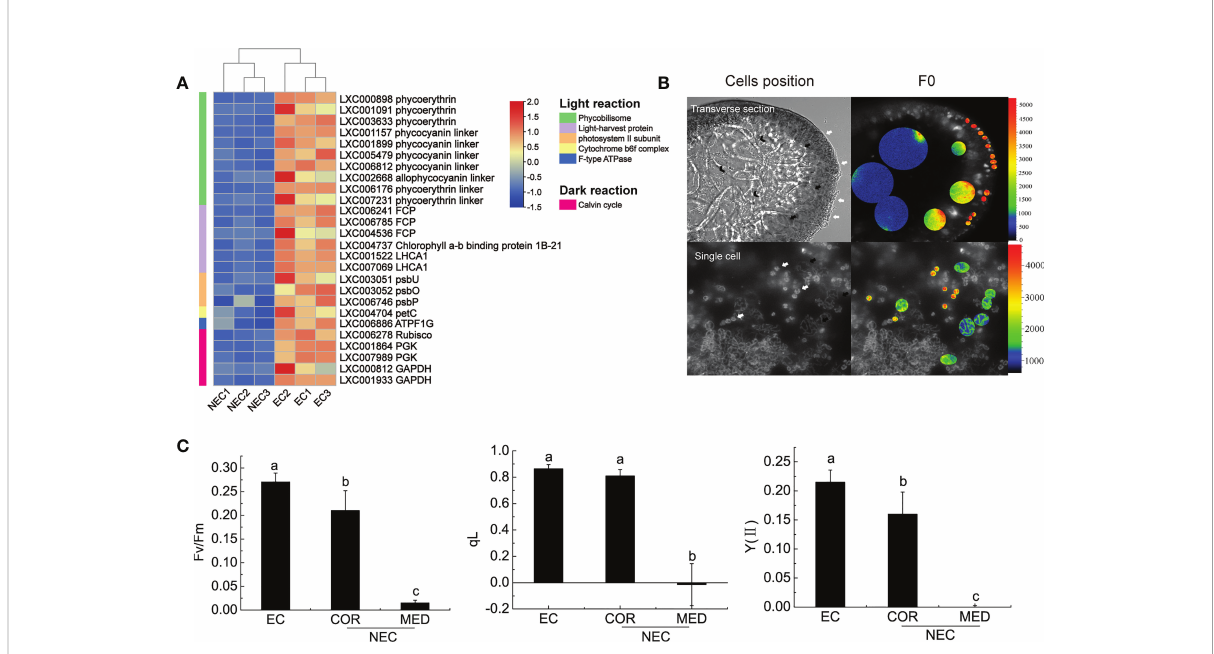
FIGURE 4 Photosynthesis of EC and NEC. (A) Heat map displaying the expression levels of differentially expressed genes (DEGs) related to photosynthesis in EC and NEC. (B) Chlorophyll fl uorescence of F 0 of EC and NEC. The colorful bars in the right of the pictures represent the fl uorescence intensity of F 0 . White arrows pointed to ECs, black arrows denoted COR, and V-shaped arrows indicated MED. (C) F v /F m , qL, and Y(II) of ECs and NECs. Different letters above the bars indicated statistically signi fi cant differences (p < 0.05) between the samples by one-way ANOVA, n ≥